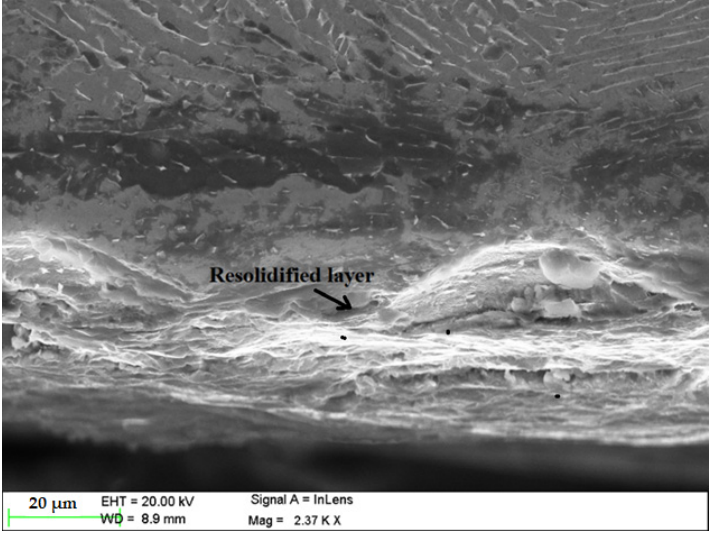
Figure 7. SEM-based surface morphology under optimal factors.